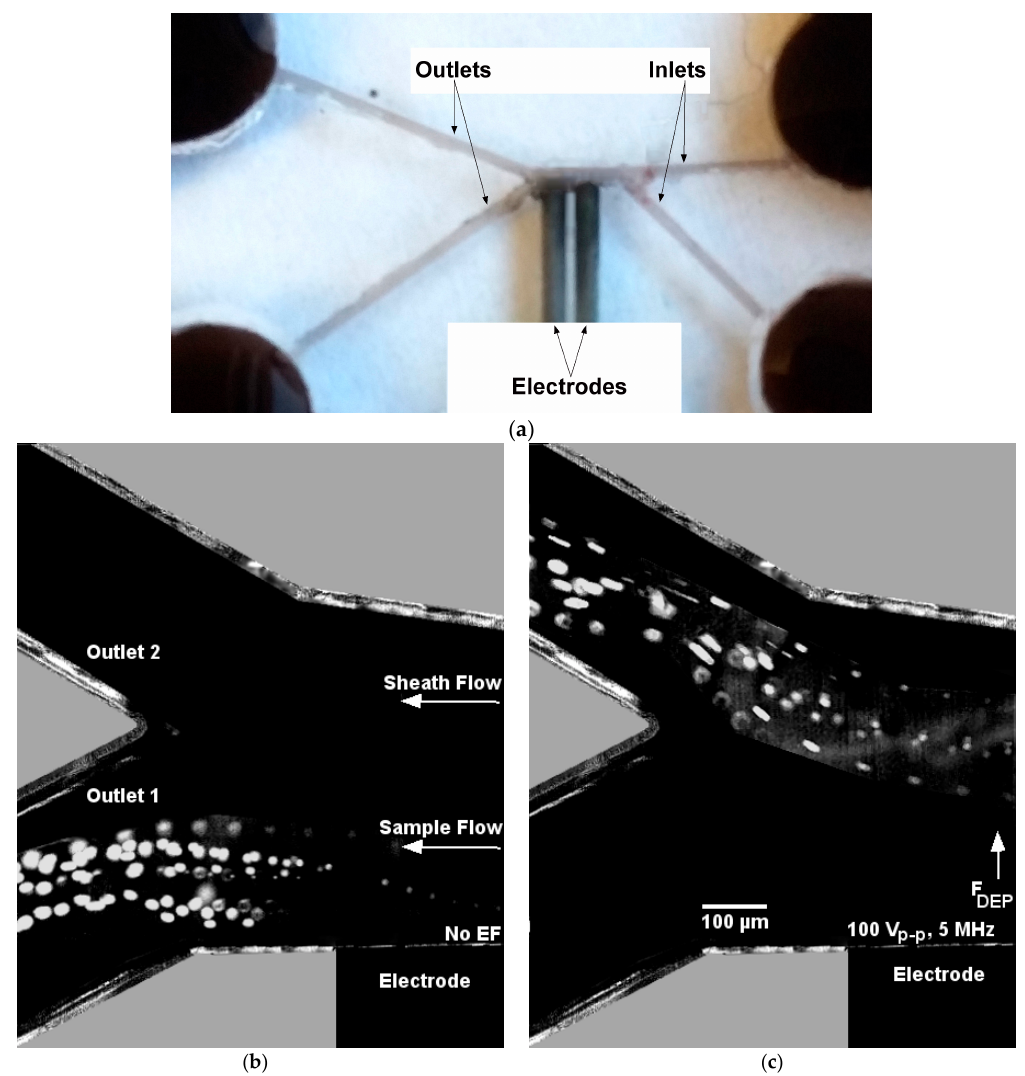
Figure 7. Microfluidic device for dielectrophoresis (DEP)-based particle switching. ( a ) A fabricated device having two inlets and outlets. Parallel pencil-lead electrodes were aligned near one outlet to apply the desired AC field in the microchannel; ( b ) superimposed trajectories of 10 µm fluorescent particles suspended in deionized (DI) water exiting the microchannel under no electric field; ( c ) DEP force generated by AC voltage of 100 V p-p at a frequency of 5 MHz repelled the particles to outlet 2.